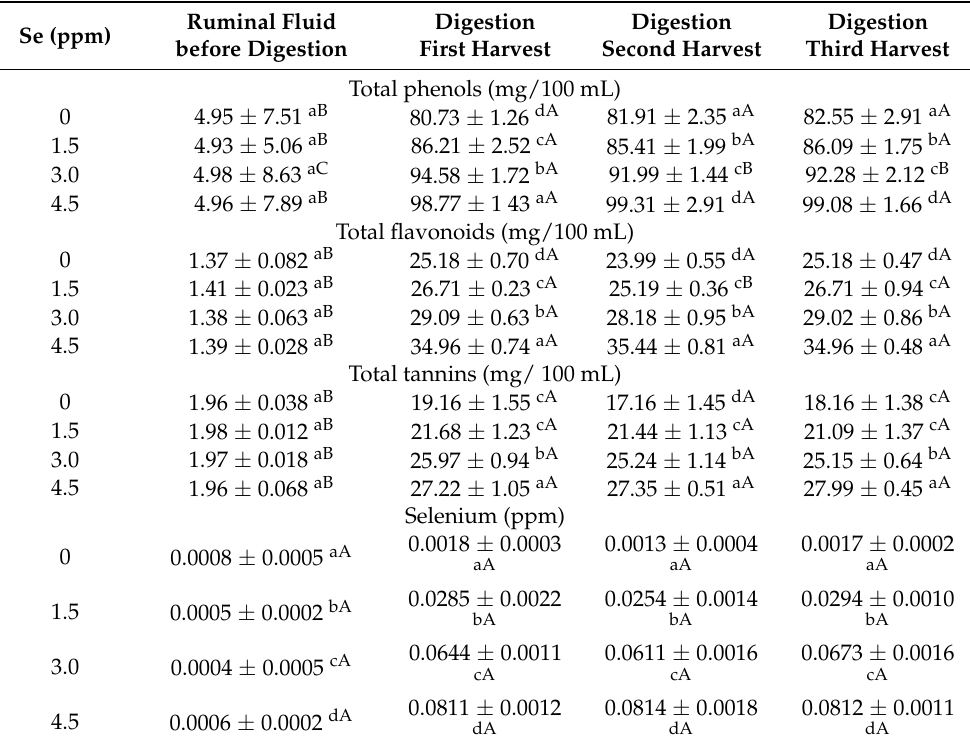
Table 3. The final concentration of total phenols, total flavonoids, total tannins, and Se after ruminal fermentation of Festuca arundinacea with Se NPs.